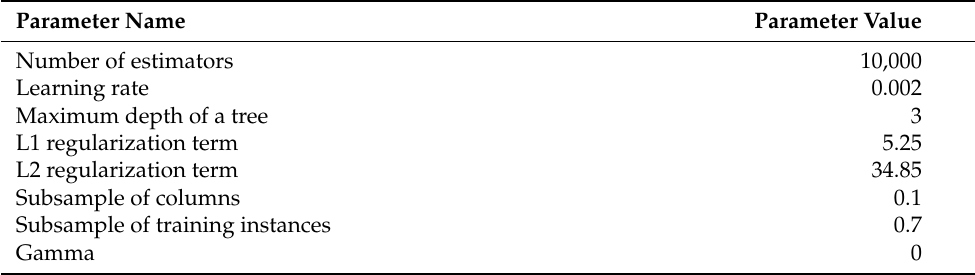
Table 3. Hyperparameters used by the XGBoost model for our